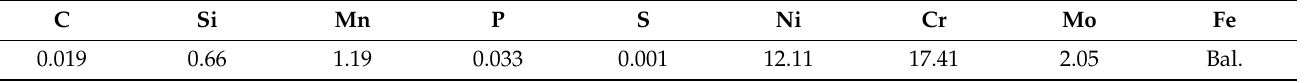
Table 2. Chemical compositions of 316L stainless steel plates